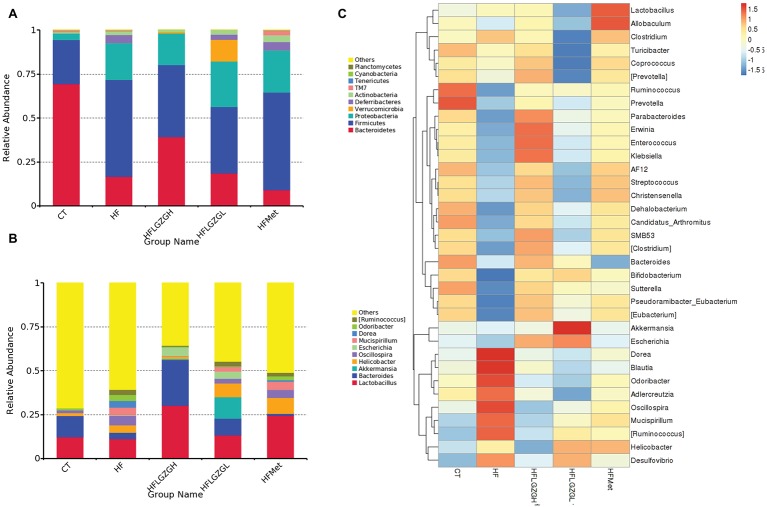
Analysis of phyla abundance in each group. (A) Relative abundance distribution of operational taxonomic unit (OTU) sequences at the phylum level from the 10 most prominent bacterial phylotypes; (B) relative abundance distribution of OTU sequences at the genus level from the 10 most prominent bacterial phylotypes; (C) comparisons of gut metagenomic profiles at the genus level on a heatmap. Mice were fed a chow diet (CT), a high-fat diet (HF), a high-fat diet and metformin (HF + Met), a high-fat diet and a high dose of Linggui Zhugan (HF + LGZGH), or a high-fat diet and a low dose of Linggui Zhugan (HF + LGZGL) for 8 weeks. There were seven mice in the HF + LGZGH group and six mice in each of the other groups.